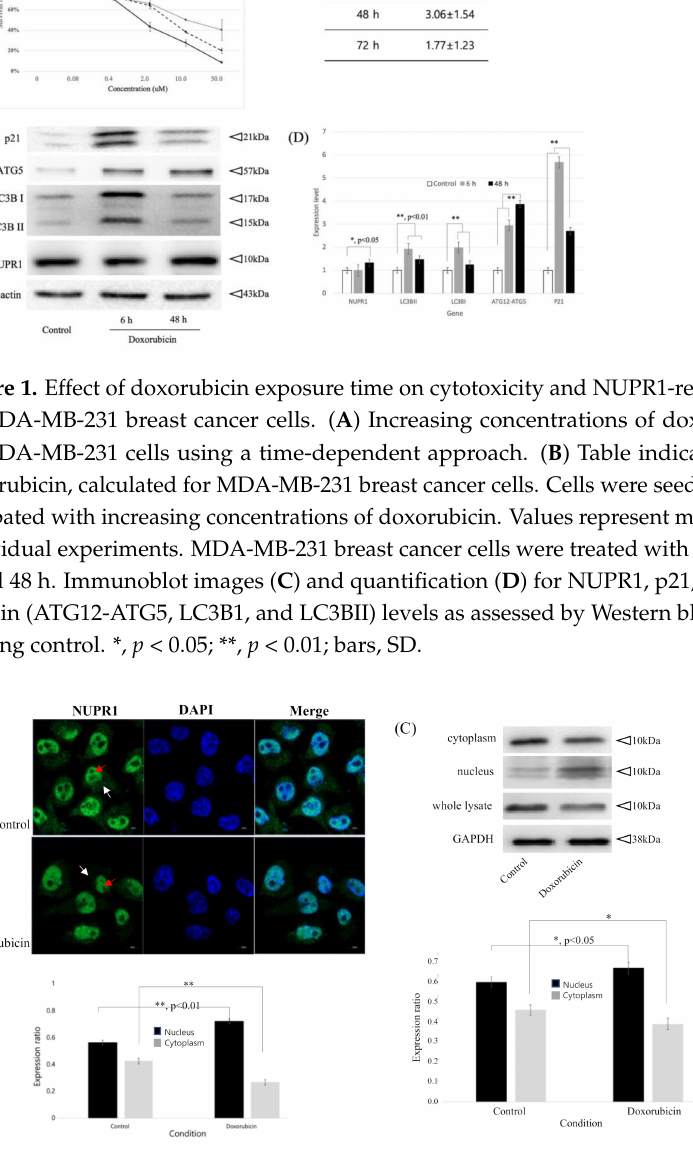
Figure 2. Cellular localization of NUPR1 protein after treatment with doxorubicin in MDA-MB231 cells. MDA-MB-231 breast cancer cells were treated with doxorubicin for 4 h. ( A , B ) NUPR1 protein was located in both cytoplasm (43.1%) and nucleus (56.9%) without doxorubicin. NUPR1 localization in the nucleus (72.9%) was increased after doxorubicin treatment (1 µ M) for 4 h, compared to cytoplasm (27.1%). Cellular localization of NUPR1 was observed under a confocal microscope. ( C ) NUPR1 protein expression in nucleus was increased following doxorubicin treatment according to Western blot analysis (compared to control). Images were obtained using a Carl Zeiss LSM 800 confocal microscope and visualized to assess protein localization. White arrow, cytoplasm; Red arrow, nucleus; *, p < 0.05; **, p < 0.01; bars,